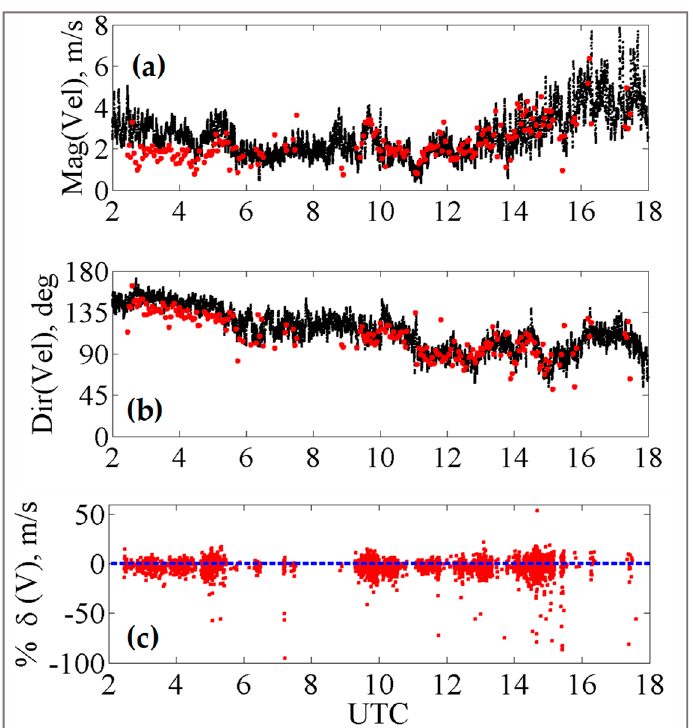
Figure 2. ( a ) Wind speed and, ( b ) wind direction (as black points) from the anemometer at 10 m height at the 2DVD location, respectively, along with the retrieved drop horizontal velocities from the 2DVD in red for D eq > 2 mm averaged over 3 min; ( c ) percentage change in the drop fall velocities from the 2DVD compared with Gunn–Kinzer.